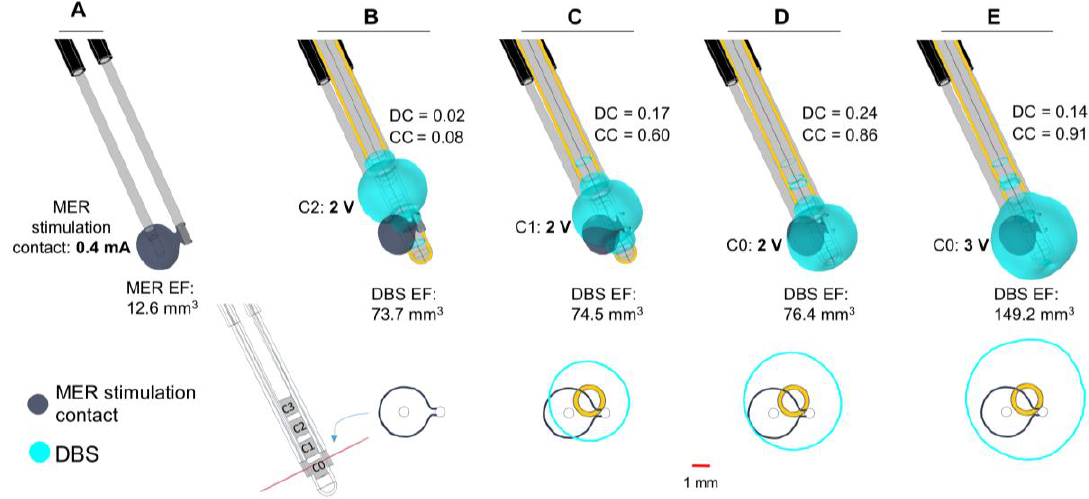
Figure 7. Clinical case. Electric field distribution depicted with 0.2 V/mm isosurfaces (upper panel) and isocontours (lower panel) obtained at the perpendicular plane placed at the middle point of the MER stimulation contact (red line). MER and DBS lead trajectories obtained from the preoperative plan and the postoperative CT scan, respectively. ( A ) Stimulation tests performed with the MER stimulation electrode placed at the optimal position determined intraoperatively: 2 mm beyond the pre-planned target on the central trajectory with a stimulation amplitude of 0.4 mA. ( B ) Overlap of the EF obtained with the MER stimulation electrode (dark blue) and the DBS contact C2 (cyan) set to 2 V, programmed six months after surgery. DBS lead placed 3 mm beyond the target (lower edge of the first contact, C0); ( C , D ) Additional comparisons using DBS contacts C1 and C0 set to 2 V and ( E ) C0 set to 3 V. EF volume within the selected isosurface shown below each lead. DC and CC shown to the right of each case.